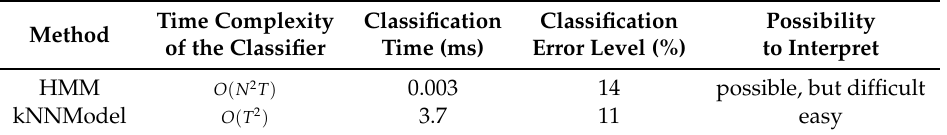
Table 2. Results of the numerical experiments and the main properties of the HMM and minimal distance kNNModel methods. The classification was performed on nine minute signal divided into two parts referring to two classes of signals (Section 2.9). In order to apply the HMM method, these parts are segmented into two second fragments corresponding to signal periods. In the HMM approach, Nis the number of states and T is the length of the string of symbols describing the signal fragments; in the kNNModel, T is the number of probes in the compared fragments of the signal. The features of the kNNModel method strongly depend on the defined distance function (see